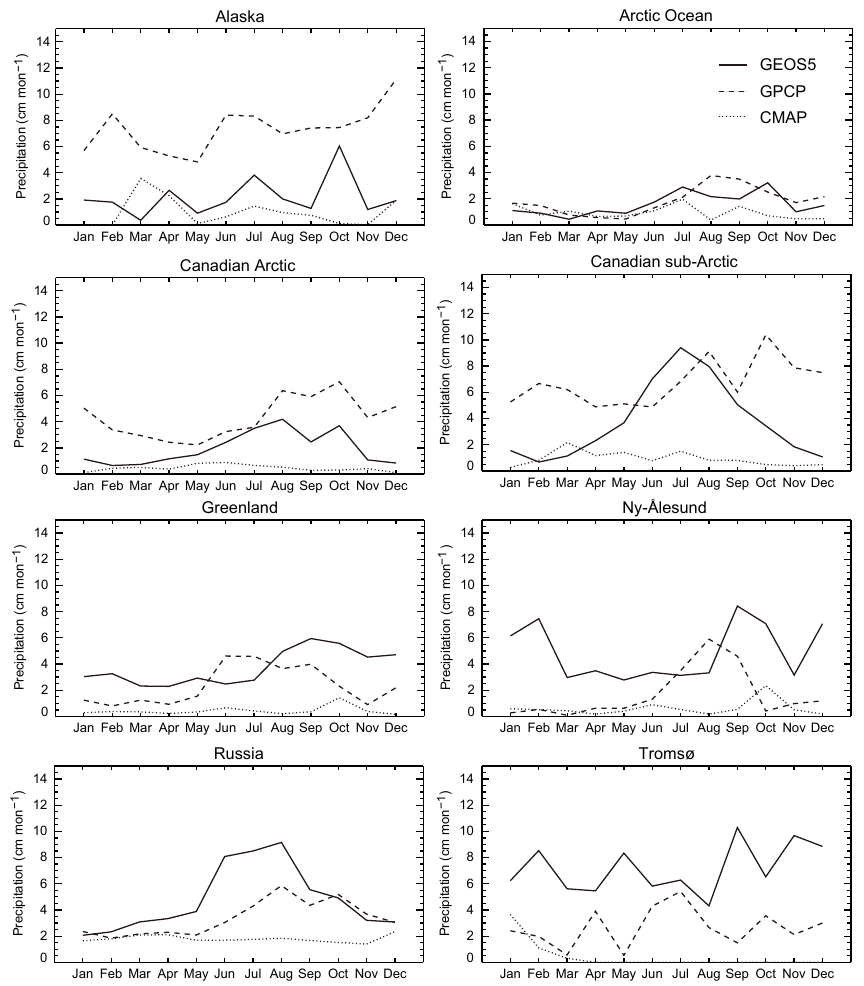
Figure 6. Monthly precipitation (cmmonth − 1 ) averaged over sub-regions in the Arctic for 2006–2008 (Fig. 1). Data are from the Goddard Earth Observing System Model version 5 data assimilation system (GEOS-5 DAS), Global Precipitation Climatology Project (GPCP), and NOAA Climate Prediction Center Merged Analysis of Precipitation